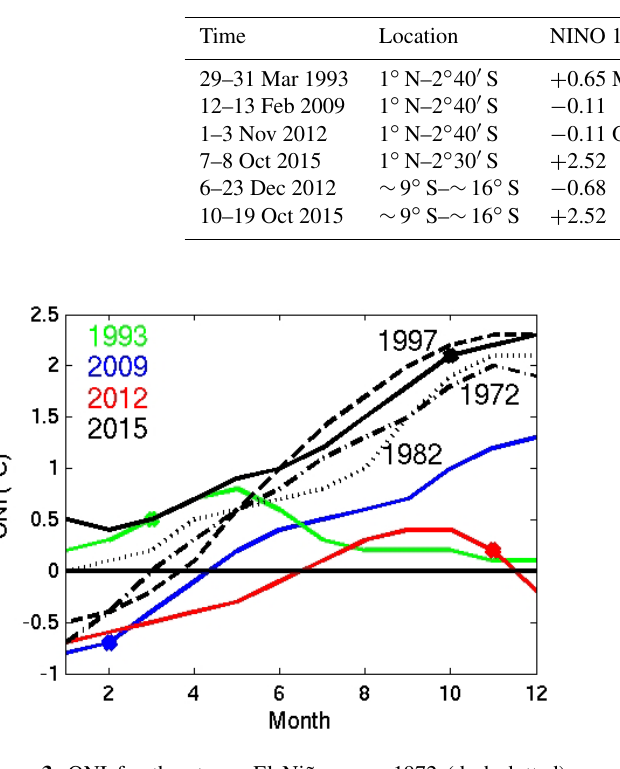
Figure 3. ONI for the strong El Niño years 1972 (dash-dotted), 1982 (dotted), 1997 (dashed), and the years used here: 1993 (green), 2009 (blue), 2012 (red), and 2015 (black line). The months of mea- surements used here are marked by colored